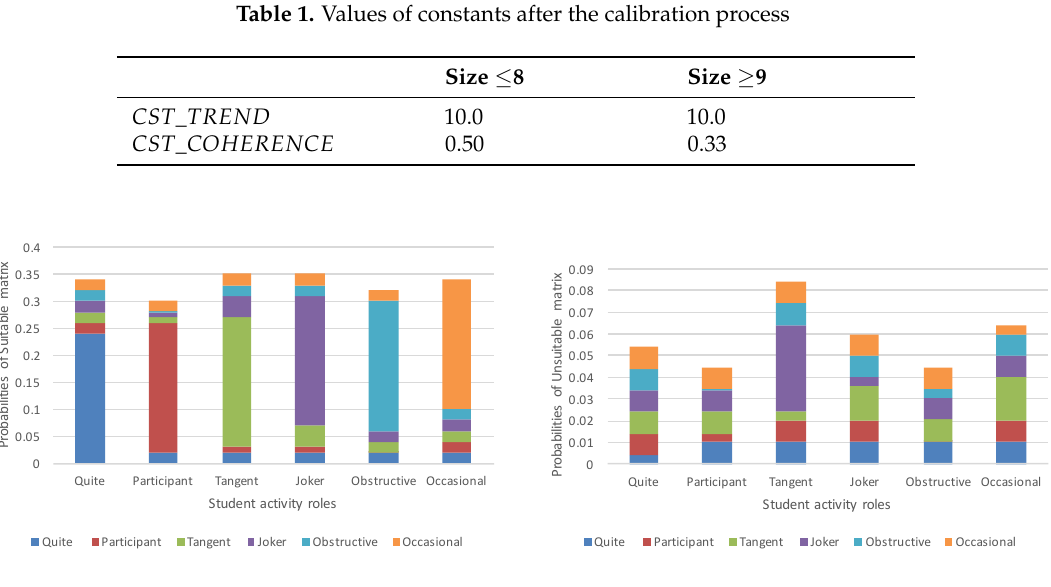
Figure 8. Charts about Suitable (in the left) and Unsuitable (in the right) matrices for large groups (i.e., size ≥ 9)